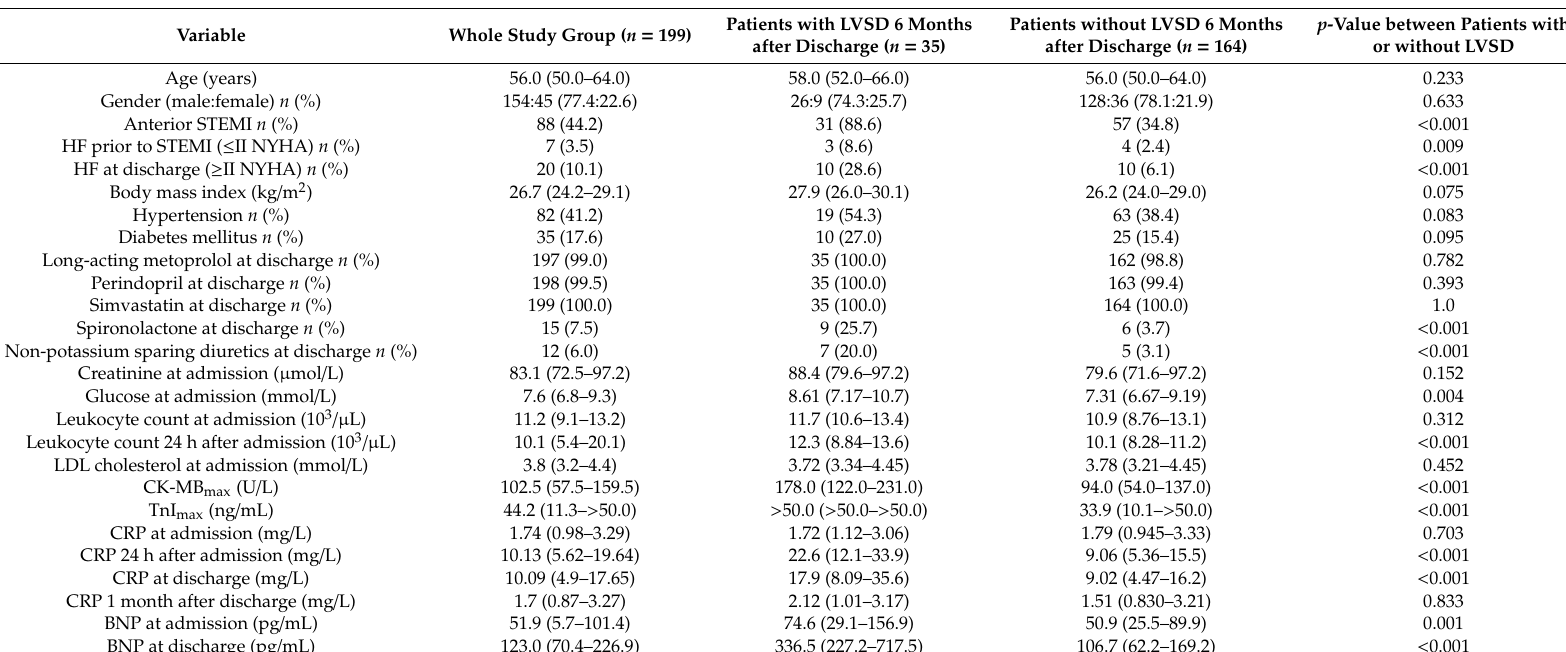
Table 1. Baseline clinical characteristics of the whole study group of patients with ST-segment elevation myocardial infarction and two patient subgroups which were found with or without left ventricular systolic dysfunction 6 months after discharge.